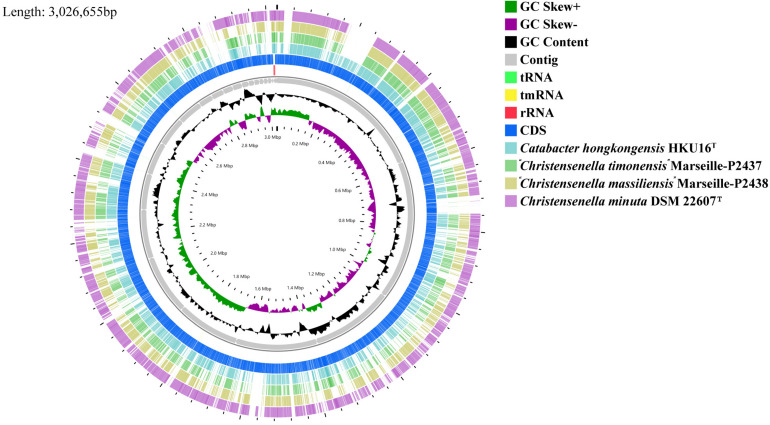
Graphical circular map of the genome from strain Christensenella intestinihominis sp. nov. AF73-05CM02T, Christensenella minuta DSM 22607T, Catabacter hongkongensis HKU16T, “Christensenella massiliensis” Marseille-P2438T, and “Christensenella timonensis” Marseille-P2437T using the CGView server using default parameters. From inner to outer: Ring 1 and Ring 2, G + C positive skew (green) and G + C negative skew (purple), respectively; Ring 3, GC% content; Rings 4–8, Contig, rRNA, tmRNA, rRNA, and CDS from AF73-05CM02T, respectively; Ring 9, Catabacter hongkongensis HKU16T; Ring 10, “Christensenella timonensis” Marseille-P2437T; Ring 11, “Christensenella massiliensis” Marseille-P2438T; Ring 12, Christensenella minuta DSM 22607T.